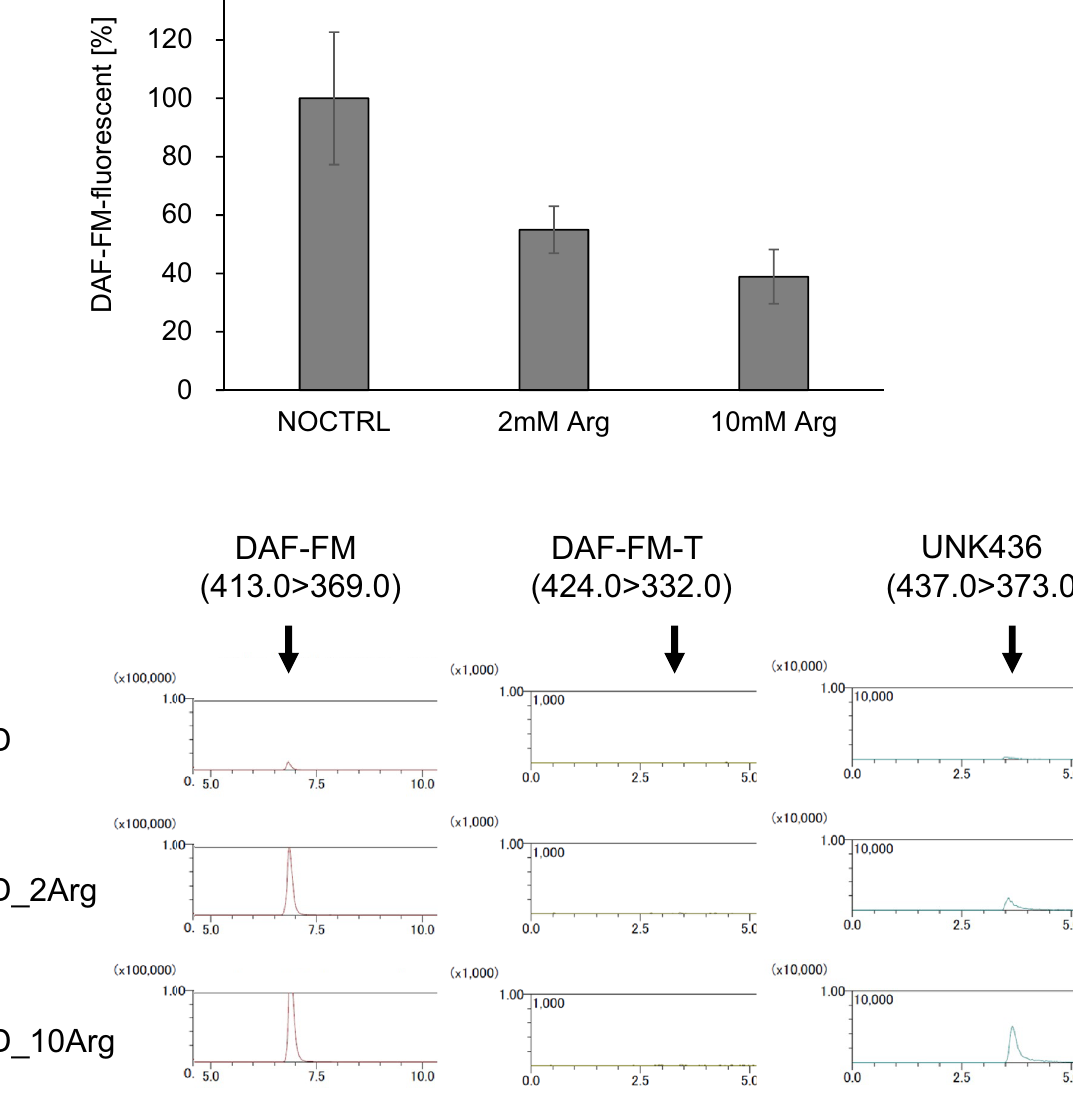
Figure 7. Detection of a DAF-FM-related product in medium supplemented with L-arginine. ( A ) Aspergillus fumigatus grown in PDB was treated with DAF-FM DA, followed by incubation with 0 mM, 2 mM, or 10 mM L-arginine (Af_DFD, Af_DFD_2Arg, or Af_DFD_10Arg, respectively). Each extract was obtained, and the DAF-FM fluorescence was quantified, as described previously. ( B ) DAF-FM, DAF-FM-T, and UNK436 were detected by the LC–MS/MS